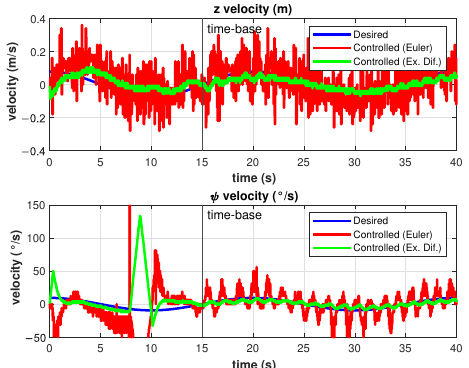
Figure 16. Velocities estimations by Euler and Exact differentiators.